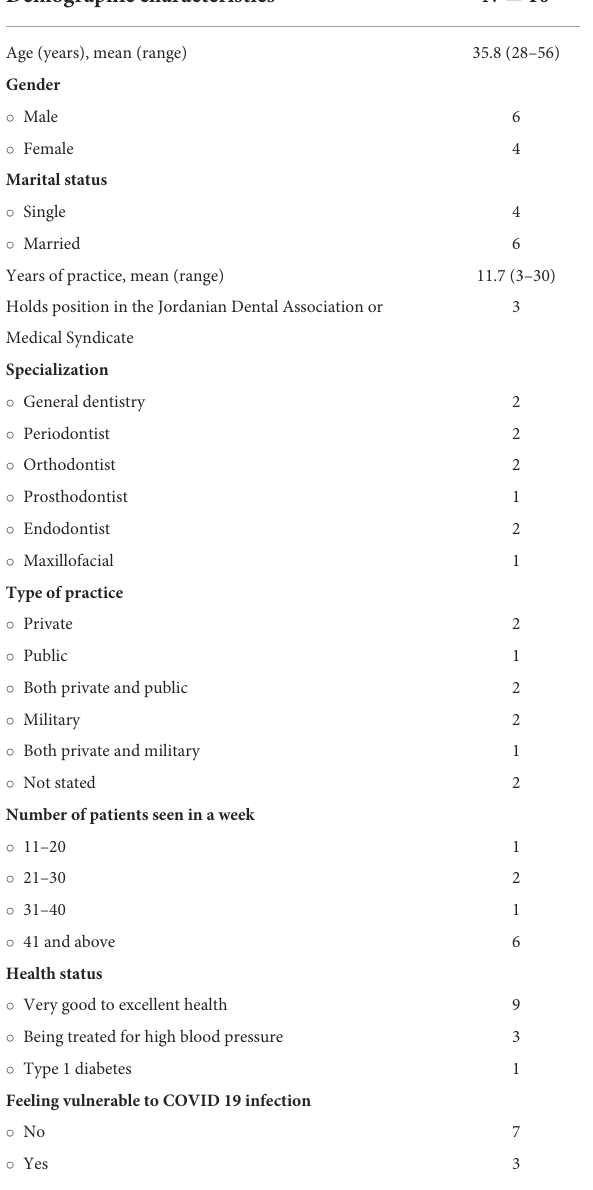
TABLE 2 Demographic characteristics of